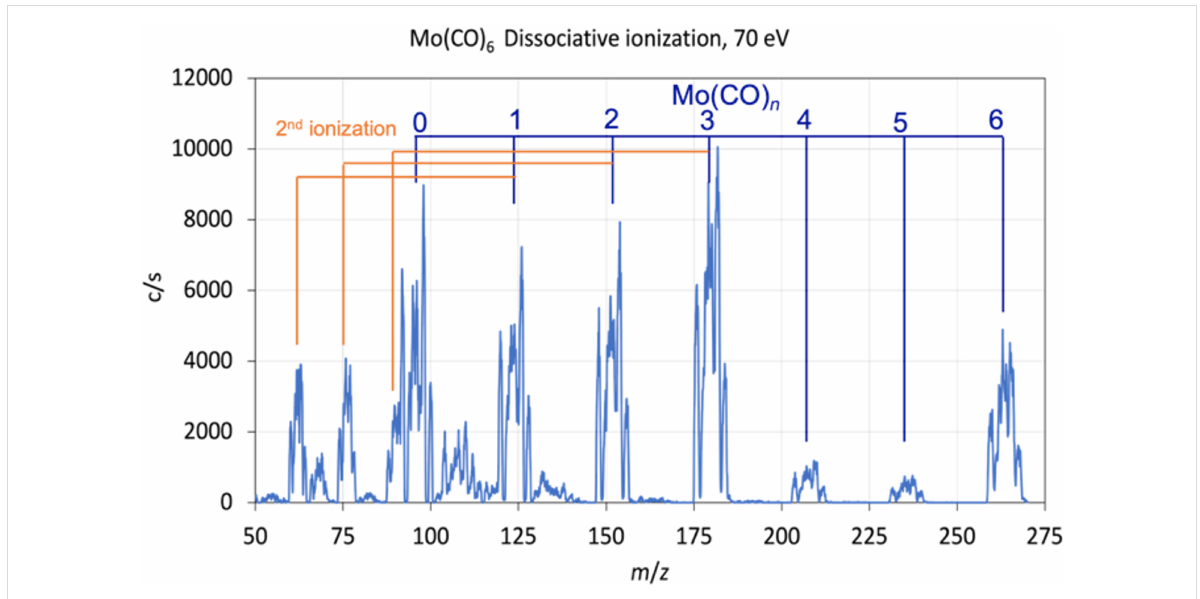
Figure 3: Electron impact ionization mass spectrum for Mo(CO) 6 recorded at 70 eV incident electron energy with the sequential carbonyl loss (one to six CO groups) and second ionizations marked with vertical